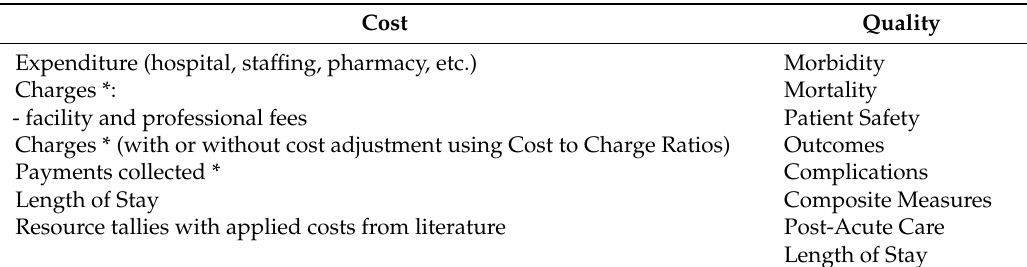
Table 1. Examples of defining cost and quality in the literature. Cost Quality